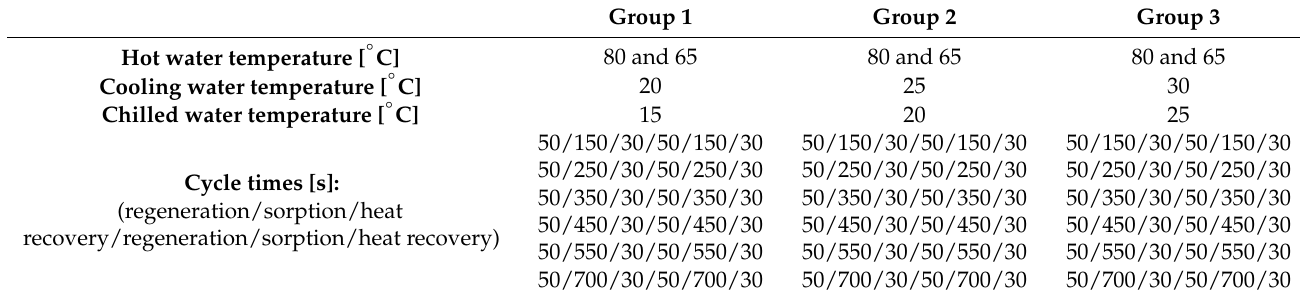
Table 4. Stage 2, experimental study